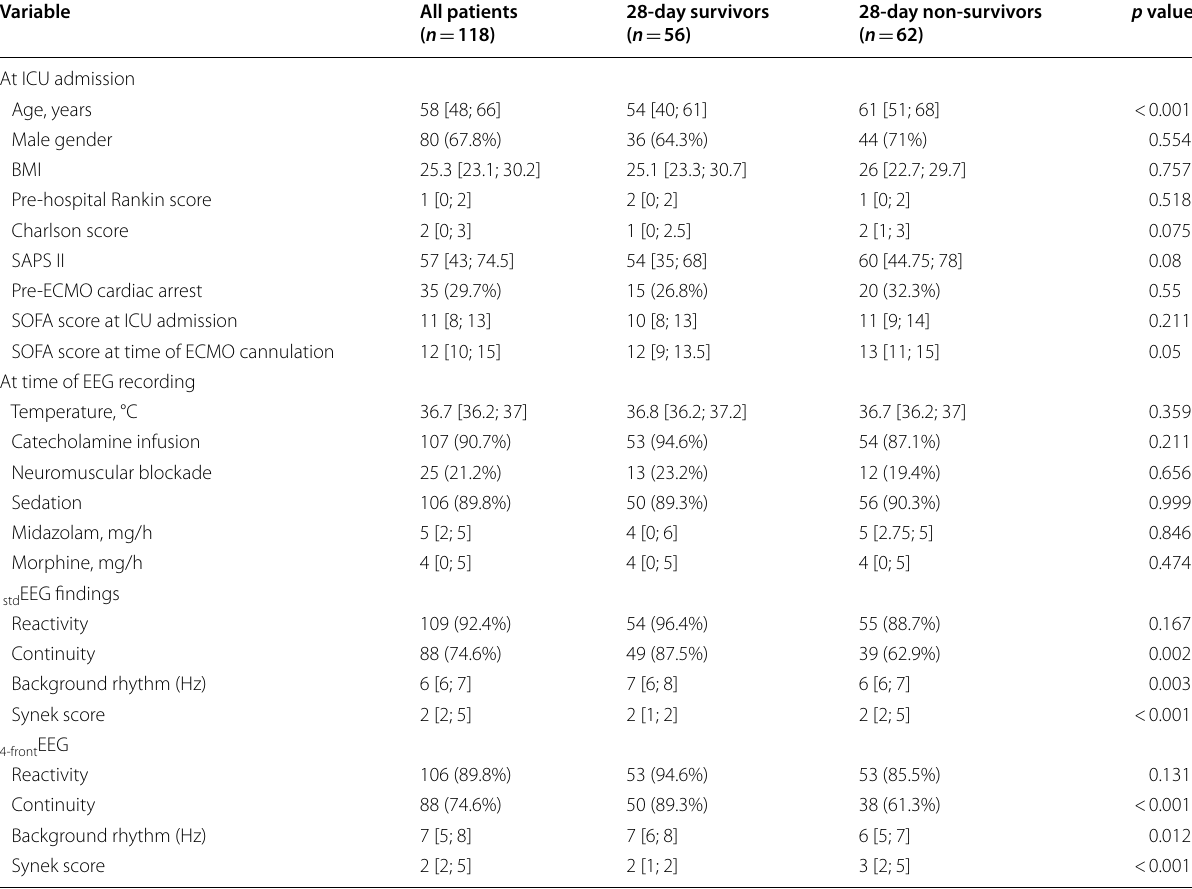
Table 1 Patient characteristics and EEG findings with respect to 28‑day